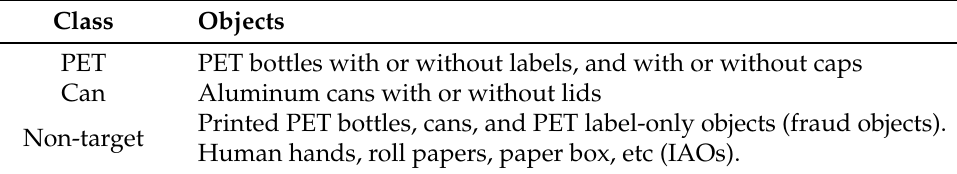
Figure 4. Actual images from the dataset: ( a ) Top view of PET and Can classes; ( b ) Top view of Non-target class with printed images of PET and can, PET label-only object, and IAO such as paper cup; ( c ) Front view of PET and Can classes; ( d ) Front view of Non-target class with printed images of PET and can, and IAO such as whiteboard eraser. Table 1. Classes and objects used in this study. The composition of objects is same on both the top view and the front